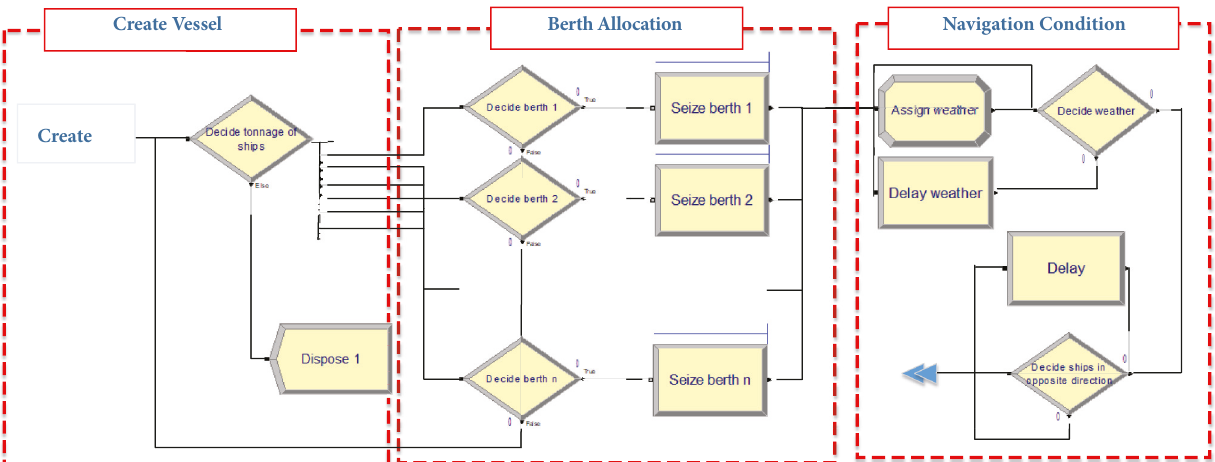
Figure 5: The ships’ arrival and departure